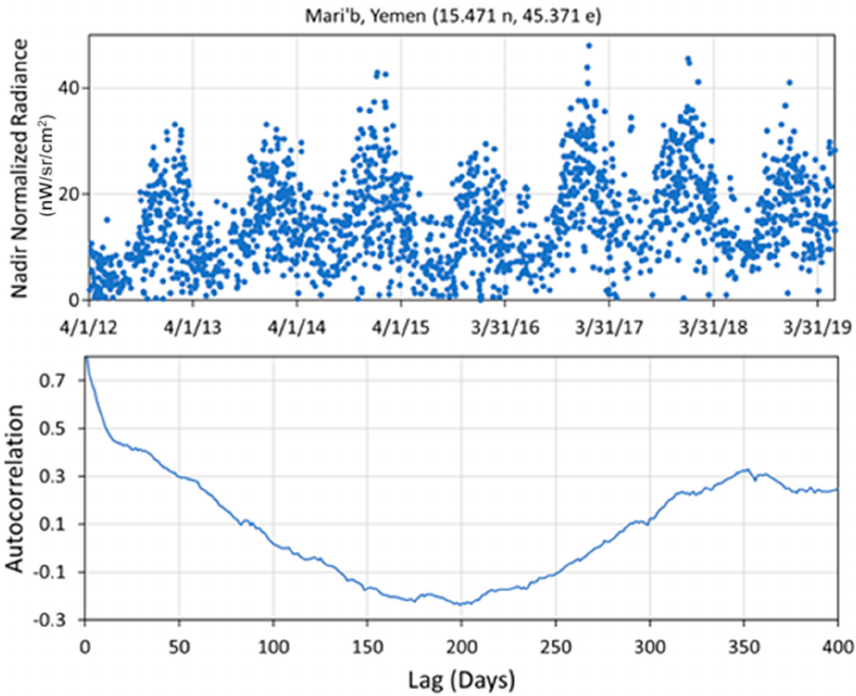
Figure 12. DNB temporal profile of a location in Yemen showing prominent annual cycles in the brightness of the lights. January is always the brightest month and July the dimmest. The lower panel shows the corresponding autocorrelation chart with a peak near the one-year mark.